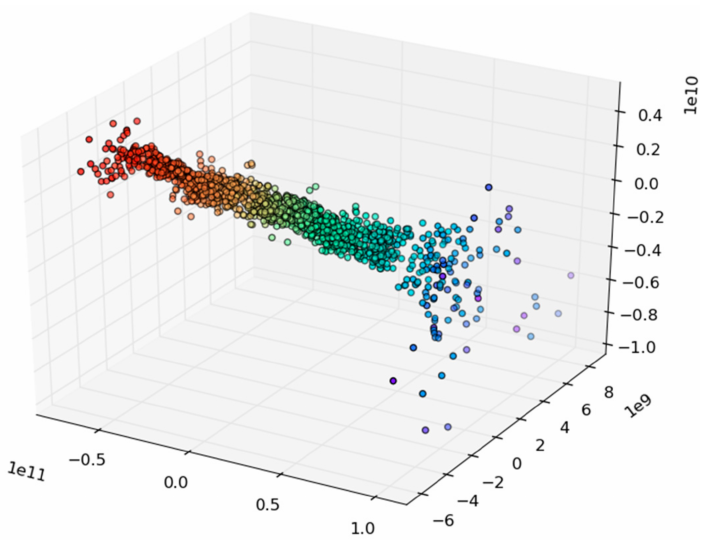
Figure 11. Multidimensional scaling illustration of the testbed communication with video and IoT